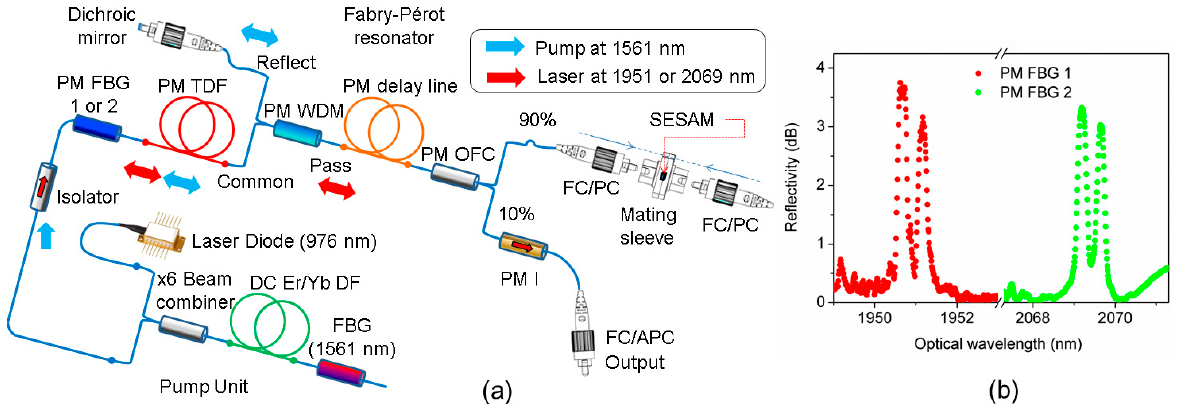
Figure 1. ( a ) Structure of the fiber laser. ( b ) Optical spectra of PM FBG 1 tuned to 1.951 µ m (red dots), and PM FBG 2 tuned to 2.07 µ m (green dots).